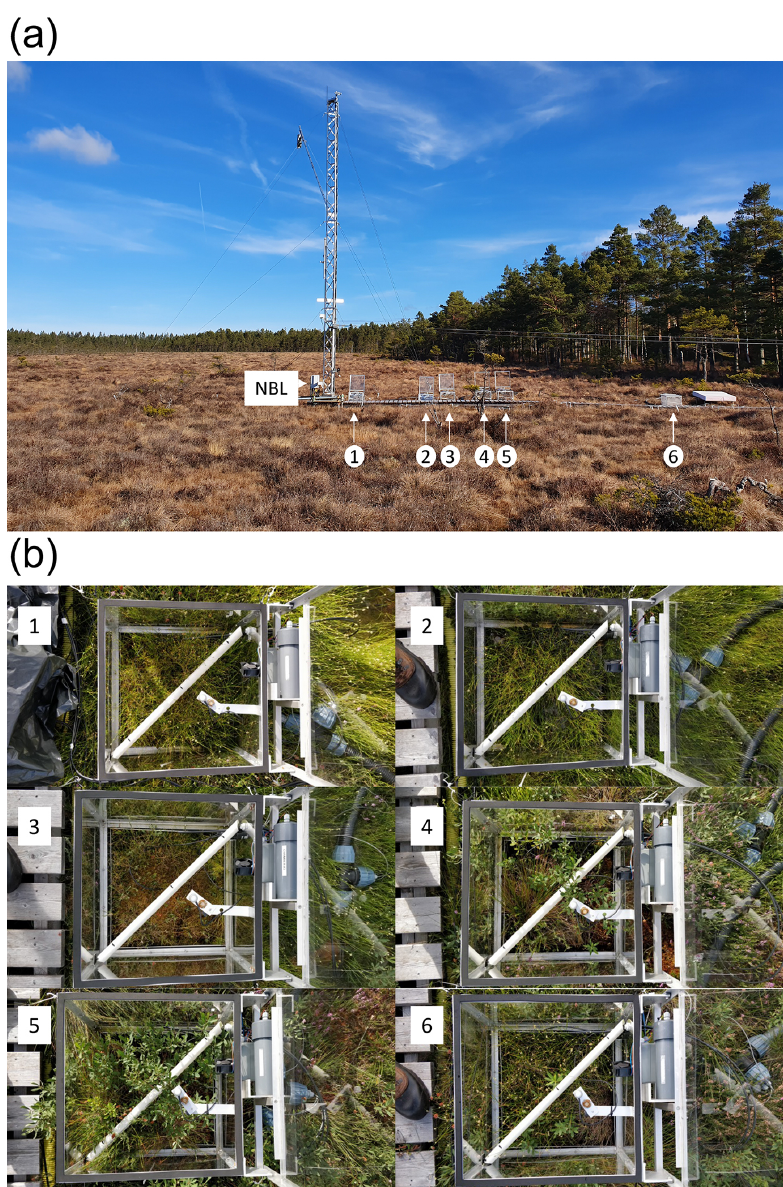
Figure 5. (a) Photo showing the relative location of chambers along the boardwalk. (b) Photos of vegetation inside each chamber, numbered 1–6. NBL indicates the inlet for measurement of ambient air for the nocturnal boundary-layer accumulation